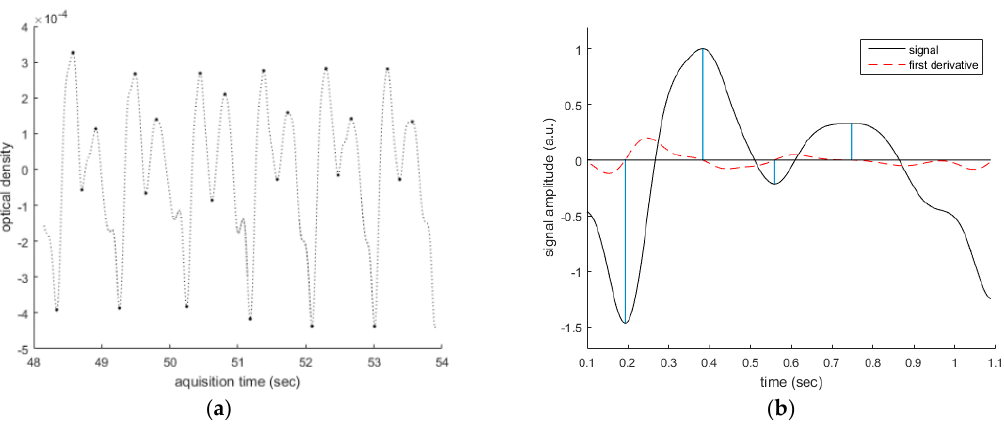
Figure 7. Representative results of FD Analysis ( b ) of the PPG signal ( a ). The analysis of the FD of the PPG signal allows the detection of the maximum and minimum points of the timeseries.